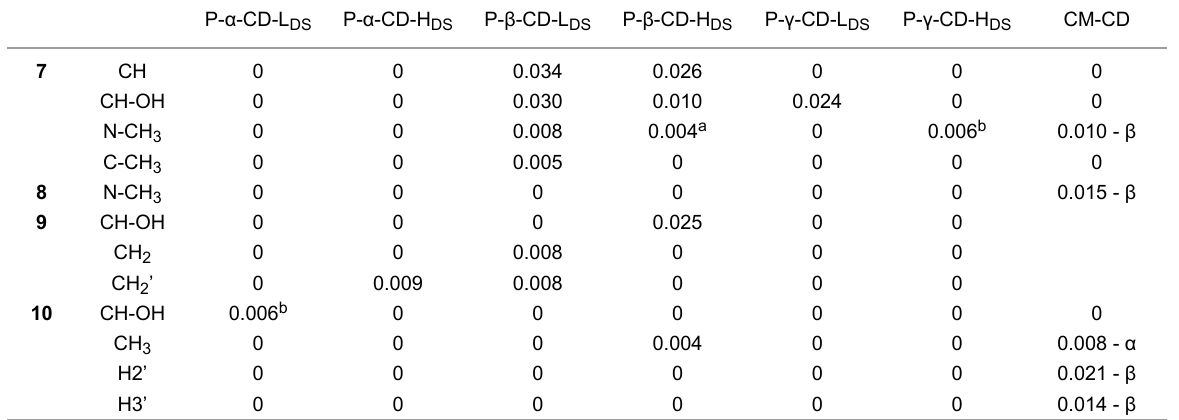
Table 2: Enantiomeric differentiation in ppm in the 1 H NMR spectra (400 MHz) of 7 – 10 (10 mM) with P-CDs and CM-CD [32] in D 2 O. The concentra- tion of the cyclodextrin is 20 mM unless otherwise